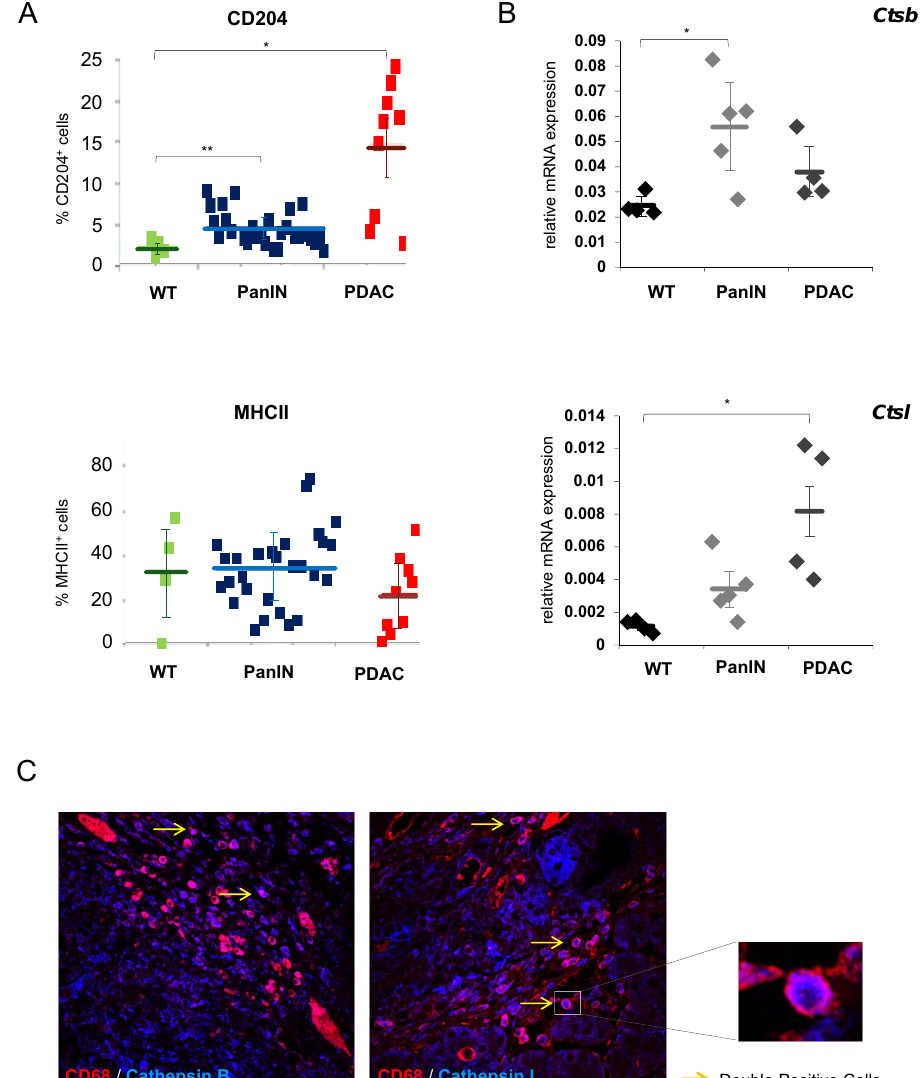
Figure 1. ( A ) During pancreatic carcinogenesis from pancreatic intraepithelial precursor (PanIN) lesions to invasive cancer (PDAC), isolated infiltrating murine CD11b + cells showed an increase in CD204, whereas MHCII expression was not significantly a ff ected. Cells from wild type mice were used as control. Data are presented as mean ± standard deviations (SD) and p -values below 0.05 were considered to be statistically significant (* p ≤ 0.05; ** p ≤ 0.01). ( B ) Changes in the expression profiles of cathepsin B and L were determined by real-time PCR in murine CD11b + cells isolated from PanIN lesions and pancreatic ductal adenocarcinoma (PDAC) lesion from KC and KPC mice. Ribosomal protein RPLP0 was used as a housekeeping gene for data normalization. Cells from wild type mice were used as control. ( C ) Representative immunofluorescence pictures showing cathepsin B and L positivity of distinct subsets of tumor-associated macrophages in human pancreatic cancer tissues. A double-staining with CD68 and cathepsin B or cathepsin L antibodies was done, and representative double-positive cells are highlighted with yellow